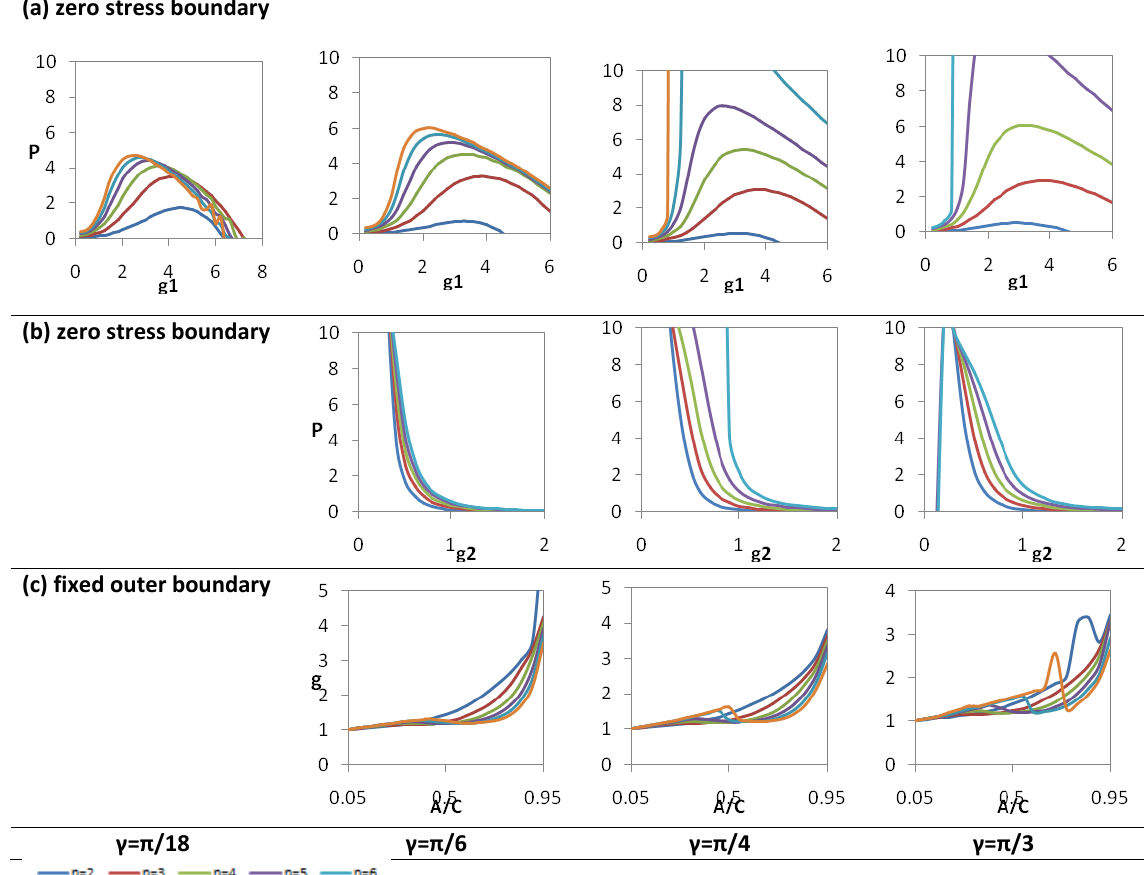
Figure 8: Summary of behavior of two-layer model. Critical buckling strain/pressure/grow rate of the inner radius plotted for various buck- ling mode. Two-layer model with growth. A=1.0, B=1.2, C=1.5. µ i =40kPa; µ o =8kPa; k 1 =1; k 2 =0.2; (a) Zero normal and shear stress bound- ary condition. Critical buckling pressure plotted against g 1 of inner layer. (b) Zero normal and shear stress boundary condition. Critical buckling pressure plotted against g 2 of inner layer. (c) Fixed outer boundary. Critical buckling growth rate (g 1 =g 2 ) of inner layer plotted against A/C. C=1.5, (B-A)/(C-A)=0.2.